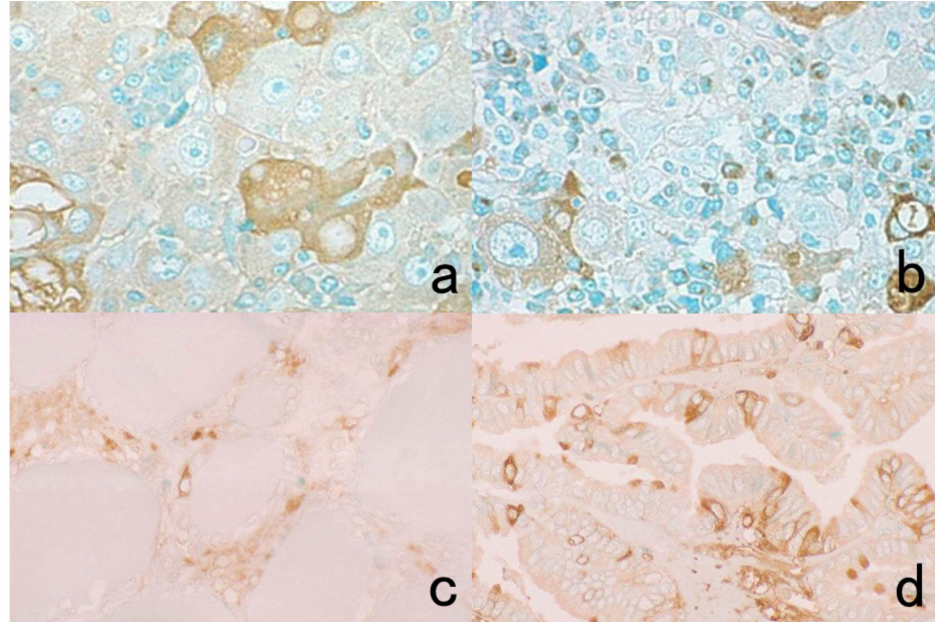
Figure 12. Diffusion artifact (II). Top panels: Albumin ( a ) and IgG ( b ) immunoreactivities in hepato- cellular carcinoma metastatic to the hepatic hilar lymph node. Bottom panels: IgA immunostaining in normal ( c ) and neoplastic ( d ) thyroid. Hepatocellular carcinoma cells, normal thyroid follicular cells, and papillary thyroid carcinoma cells reveal diffuse cytoplasmic staining for the plasma proteins (albumin, IgG, and IgA) in some cells. The nuclei remain negative. The Golgi area of plasma cells is immunoreactive for IgG in panel ( b ). The nuclei are counterstained with methyl